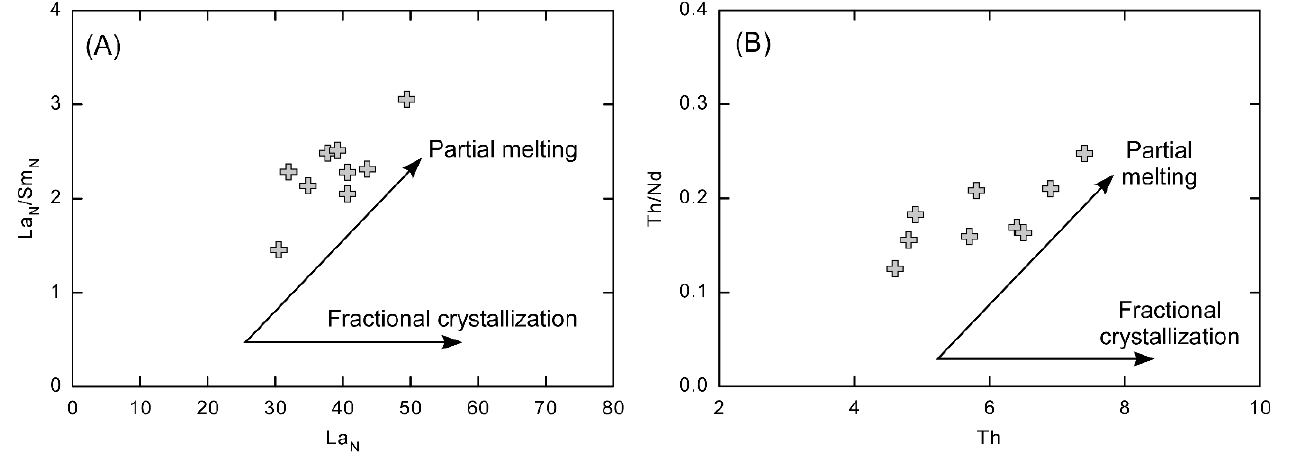
Figure 11. Binary relation between (La) N vs. (La/Sm) N ( A ) and Th vs. Th/Nd ( B ), showing that partial melting is the major magmatic process to control the formation of the Haweit granodiorites.